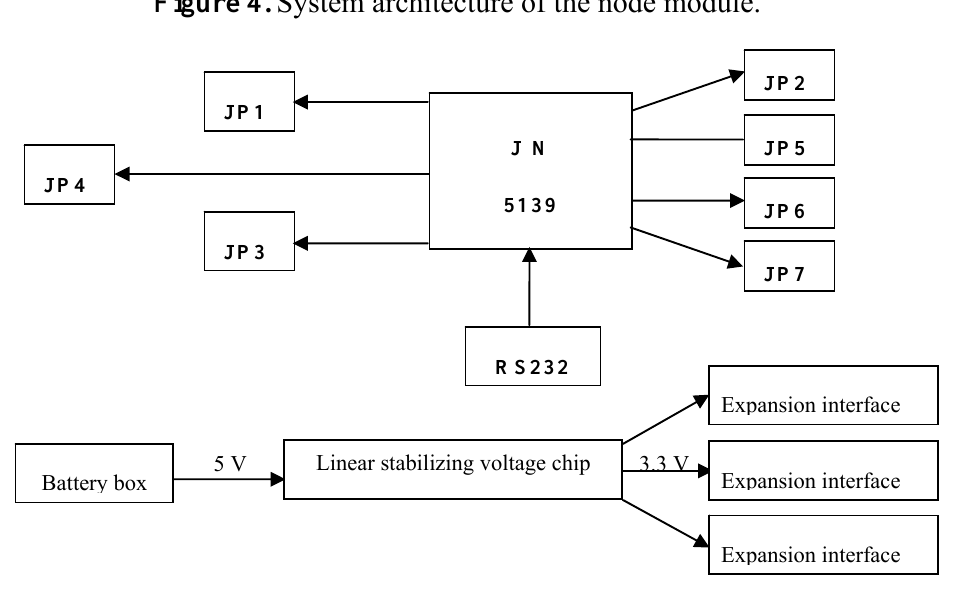
Figure 4. System architecture of the node